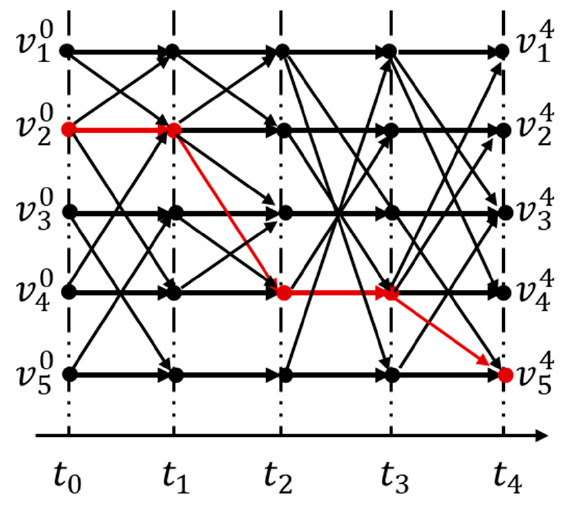
Figure 1. Space–time graph model. Figure 1. Space-time graph